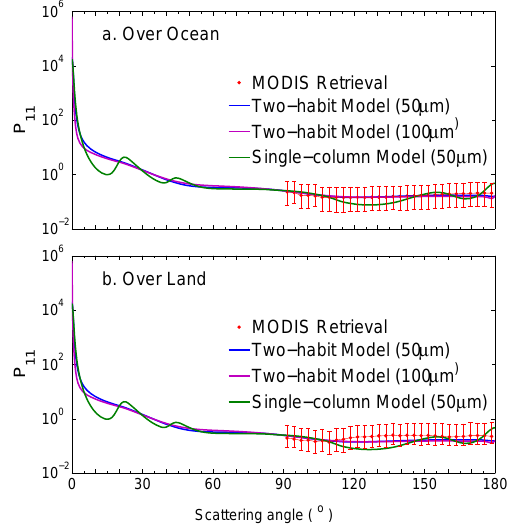
Figure 11. Comparison between the phase functions from the nu- merical models (both single-column and two-habit models) and MODIS retrieval at a wavelength of 1.38µm (Wang et al., 2014). The effective diameter used for the THM is